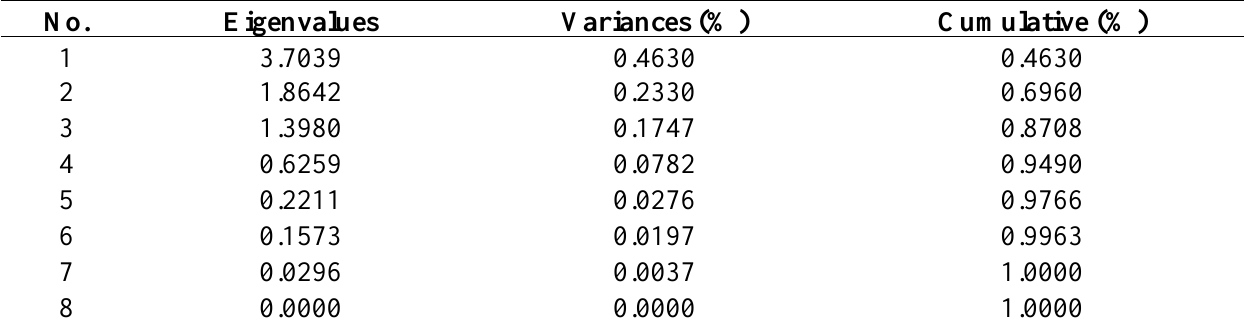
Table 4. Eigenvalues and cumulative contributions of variances.